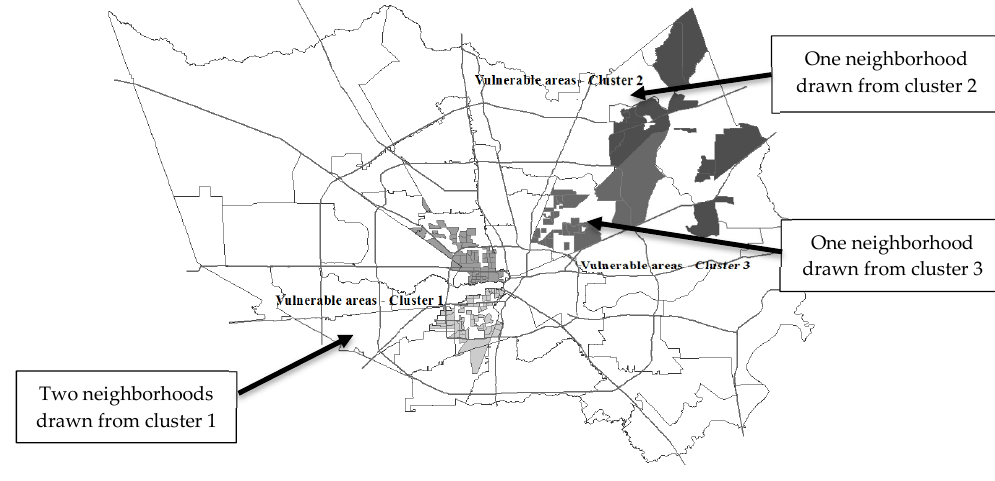
Figure 4. Most vulnerable areas, based on % residents who match cluster profiles.